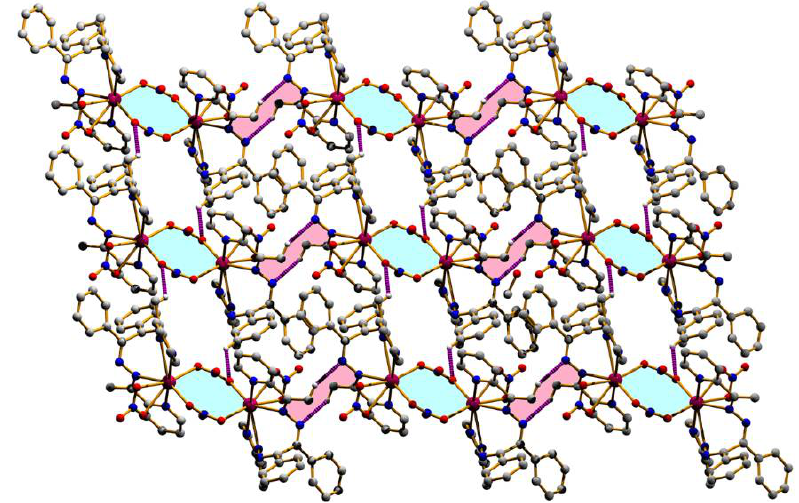
Figure 5. Two-dimensional framework generated through C‒H∙∙∙O and C‒H∙∙∙N hydrogen bonds in the (011) plane.